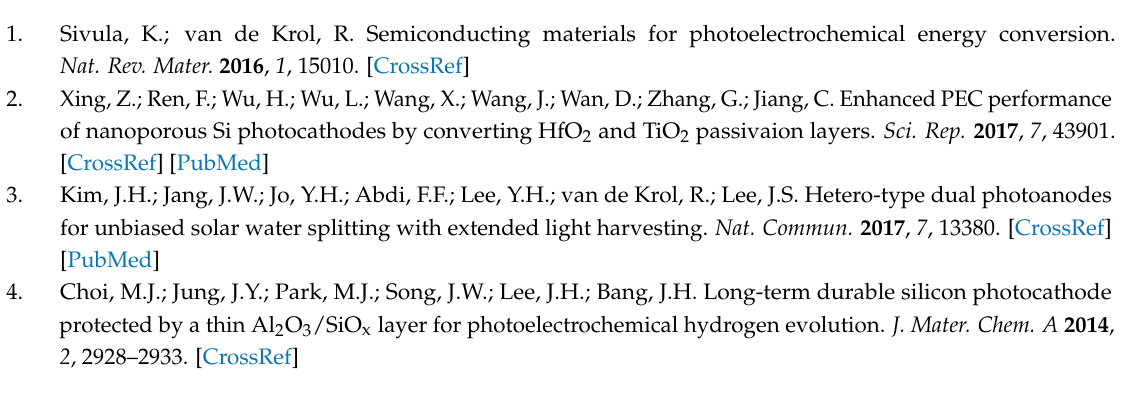
Figure S1: Schematic energy level diagram of the band alignment at p -Si/MoS 2 interface in terms of vacuum level and normal hydrogen electrode level in electrolyte of pH = 0.3. The p -Si doping level is ~1.6 × 10 15 cm − 3 , Figure S2: ( a ) Nyquist plot of 700–ALD-cycles and 300-ALD-cycles on p -Si photocathode under 1sun illumination at 0 bias. ( b ) Equivalent circuit corresponding to the EIS measurement. R bulk is bulk resistance of the silicon, Q jc is constant phase element (CPE) of p -Si/MoS 2 junction along with junction resistance R jc , CPE of MoS 2 /electrolyte interface is denoted as QMoS 2 and the resistance of R Mos2 , Table S1: Measured charge transfer